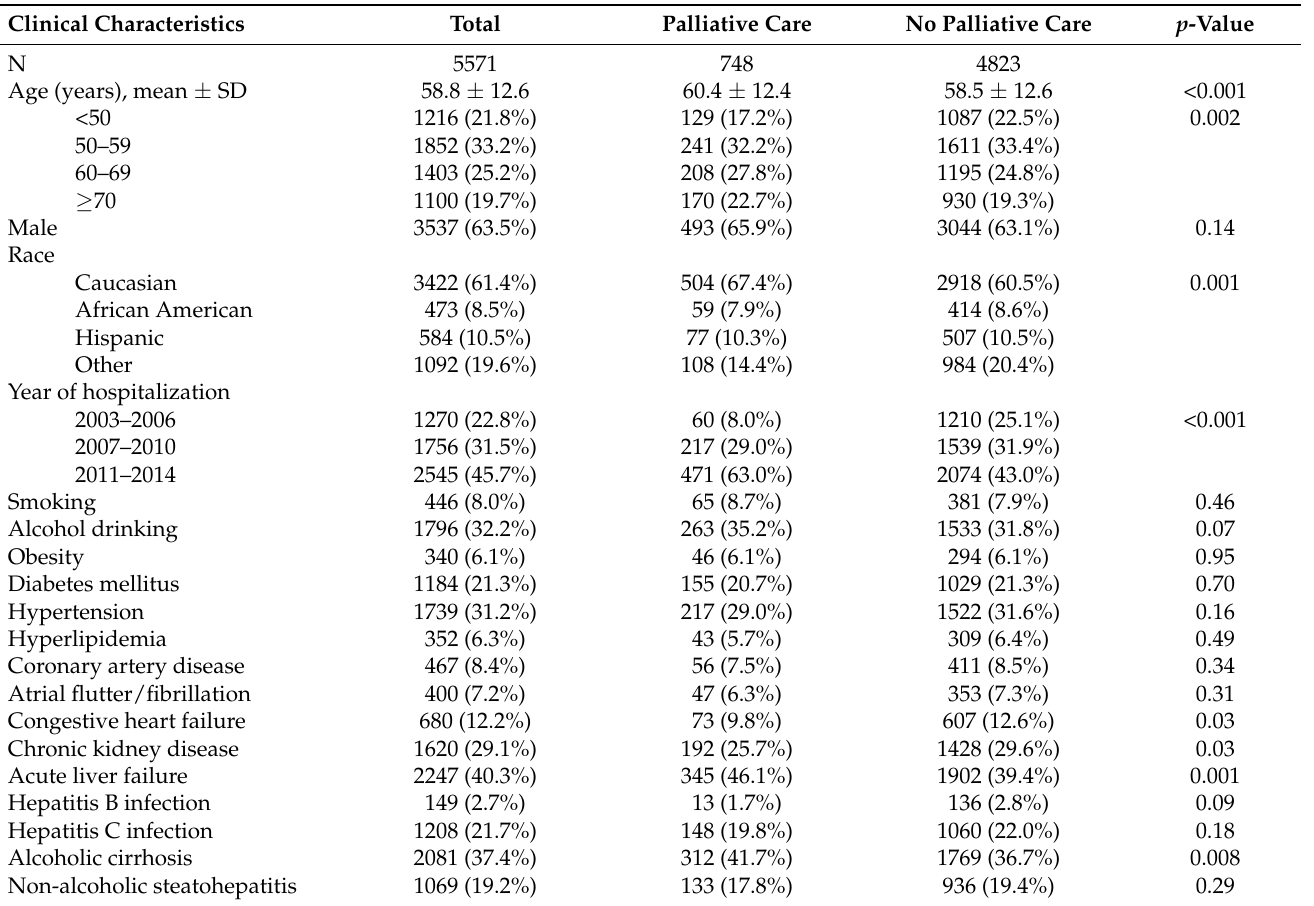
Figure 1. The rate of palliative care service use in hospital admission for hepatorenal syndrome in United States from 2003 to 2014. Table 1. Clinical characteristics, in-hospital events, and organ dysfunction between hospital admissions for hepatorenal syndrome with and without palliative care service